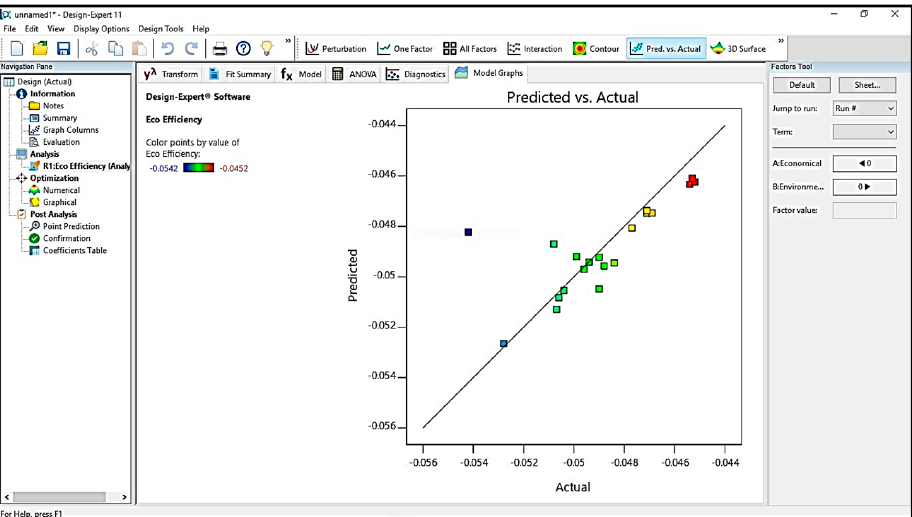
Figure 7. Predicted vs Actual Relationship.